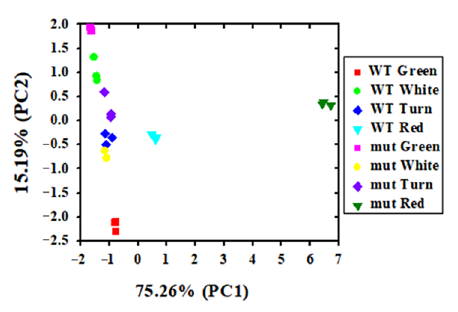
Figure 3. Principal component analysis of relative contents of nine categories of volatile compounds in ‘Benihoppe’ and ‘Xiaobai’ (WT: ‘Benihoppe’; mut: